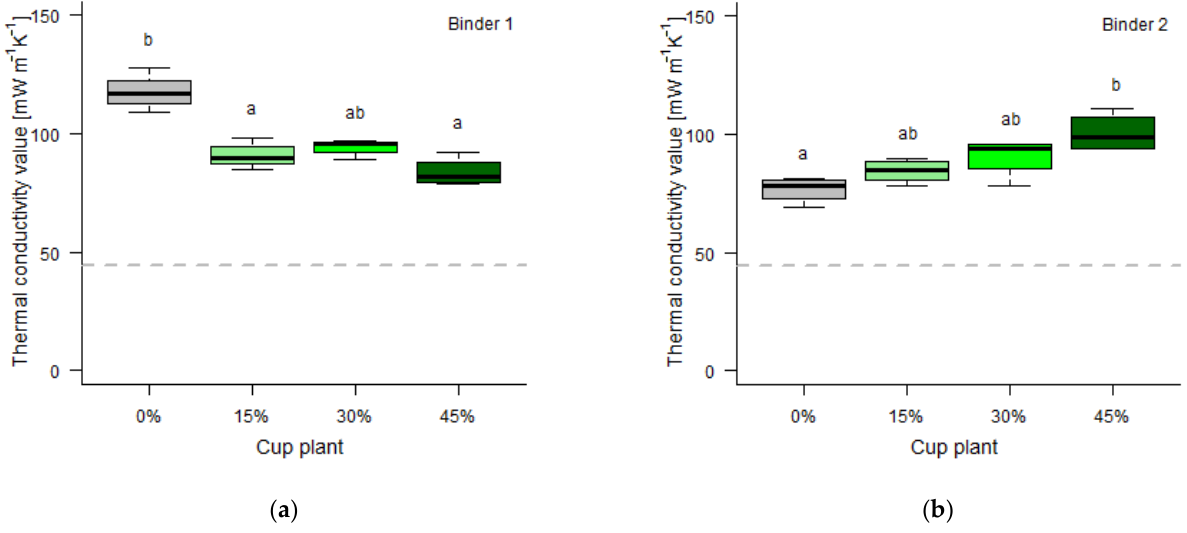
Figure 10. Boxplot of the thermal conductivities [mW m − 1 K − 1 ] of bonded leveling compound slabs produced with cup plant ratios of 0–45%. The grey lines represent reference values of the pure EPS control (45 mW m − 1 K − 1 ) [69]. ( a ) Thermal conductivity values of Binder 1 ( b ); Thermal conductivity values of Binder 2 ; differences in values followed by a different letter for each batch are statistically significant at p < 0.05 [(Tukey grouping), n = 4].